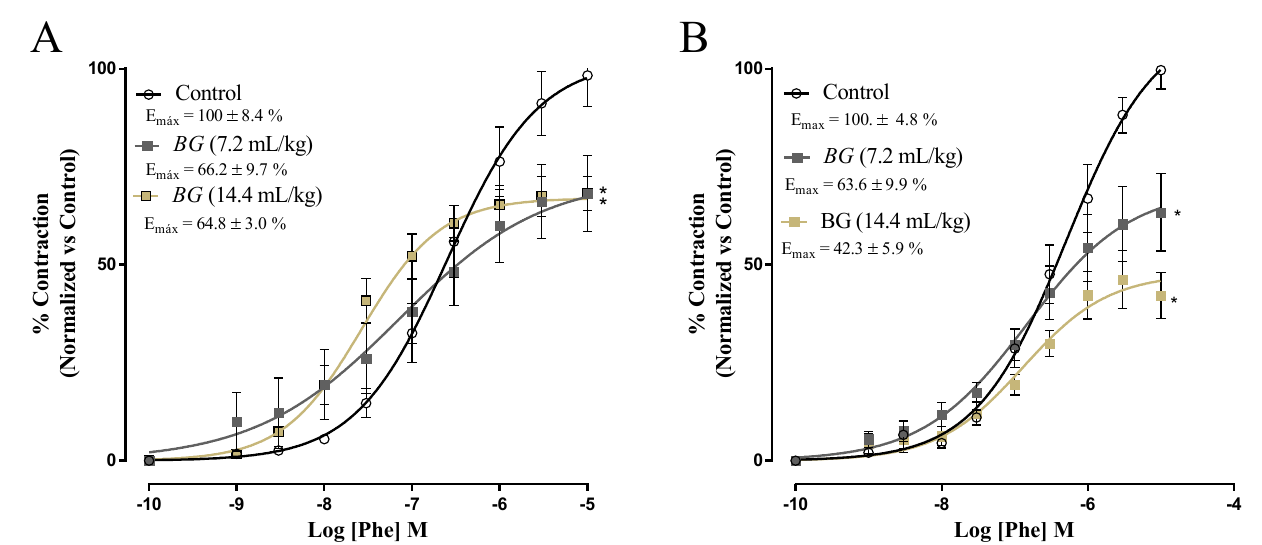
Figure 3. Effects of Baru almond oil ( Dipteryx alata Vog . ) on endothelial function in male rats. Eval- uation of vascular reactivity in aorta artery rings. Concentration–response curve to phenylephrine with ( A ) and without functional endothelium ( B ). * p -value < 0.05 vs. control group. The vascular relaxation assessed with functional endothelium using acetylcholine is demonstrated in Figure 4A. Baru oil treatments did not alter the Emax response and po- tency indicated by pD2 (Figure 4A). The vascular relaxations assessed in aorta rings with- out functional endothelium using sodium nitroprusside are demonstrated in Figure 4B. Baru oil treatments did not modify the Emax response, but the potency indicated by pD2 was increased in rats receiving Baru oil treatment at 14.4 mL/kg (Figure 4B).